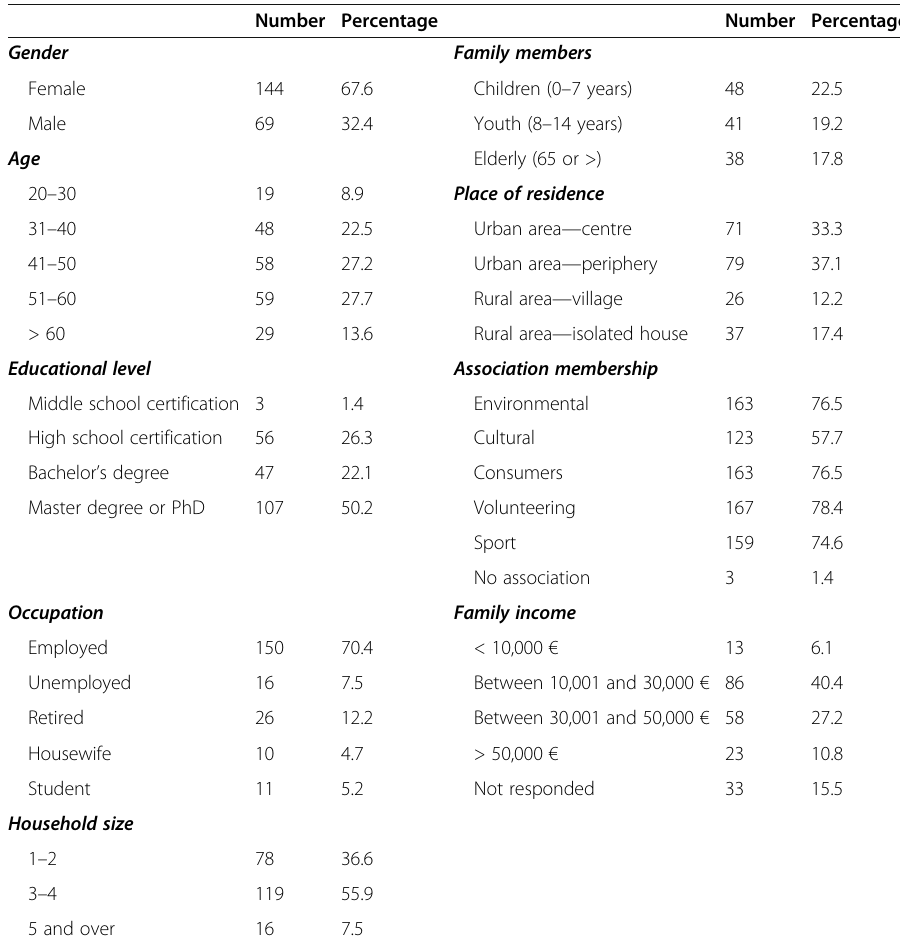
Table 2 Interviewee